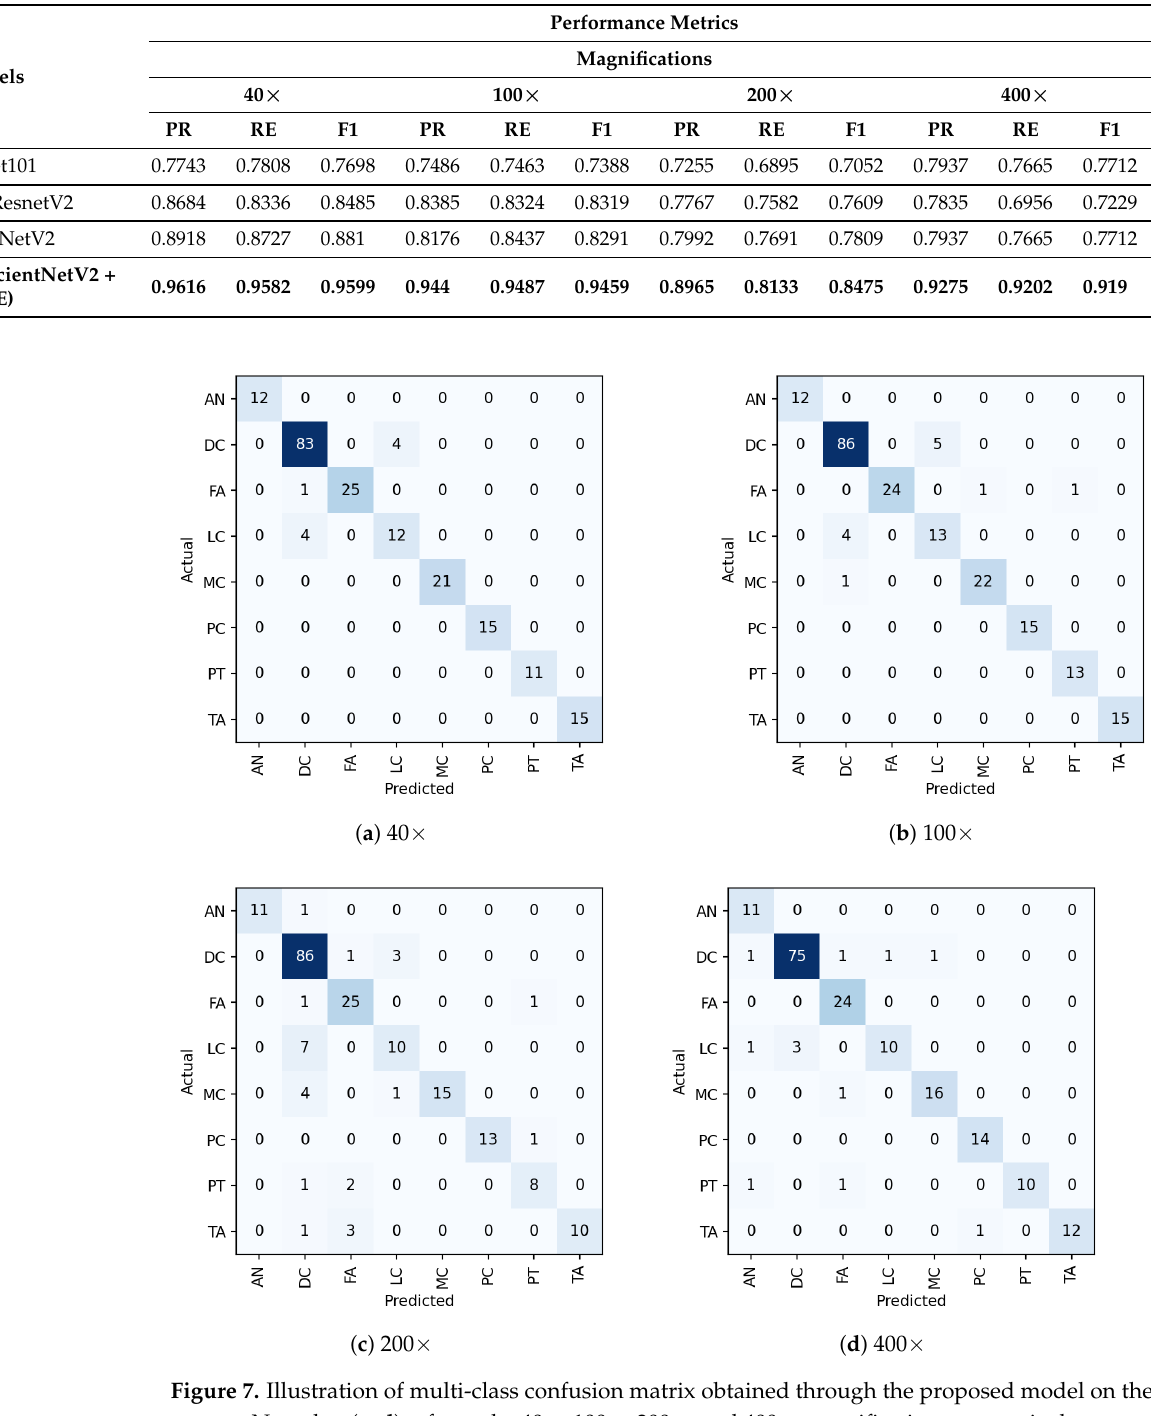
Table 3. Classification performance of the proposed model compared with three state-of-the-art models to diagnose eight types of benign and malignant breast cancer in histopathology images. The most significant results are highlighted in bold.